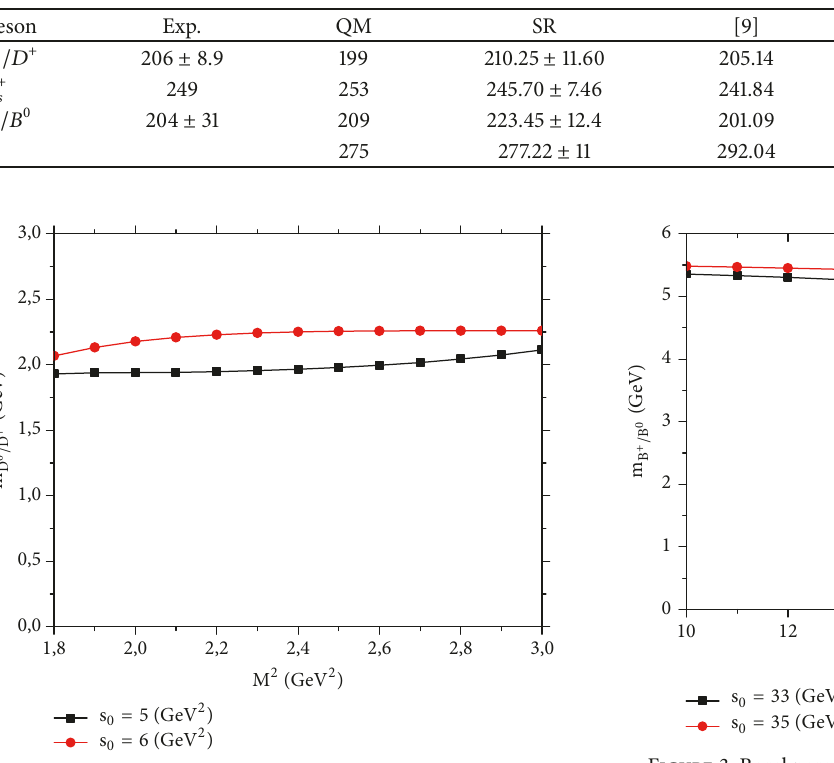
Figure 1: Borel parameter dependence of the 𝐷 0 /𝐷 + masses.